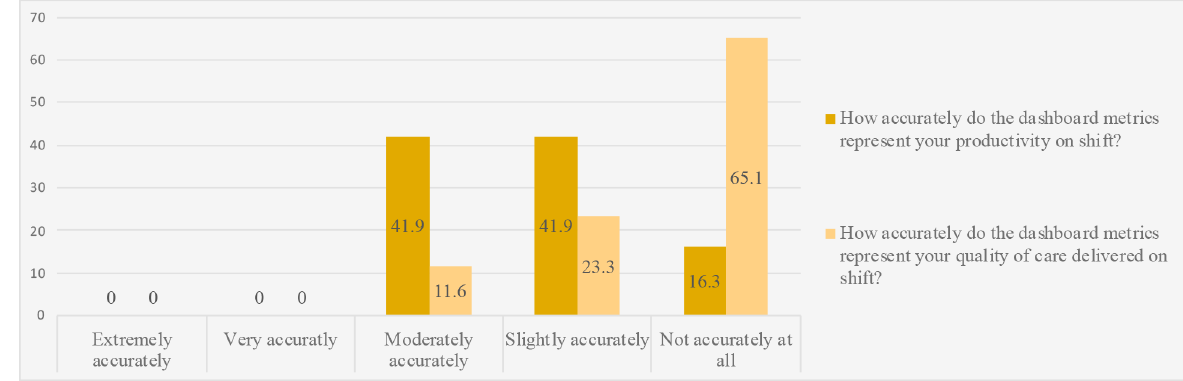
Figure 1. Residents’ perceptions of the accuracy of a productivity